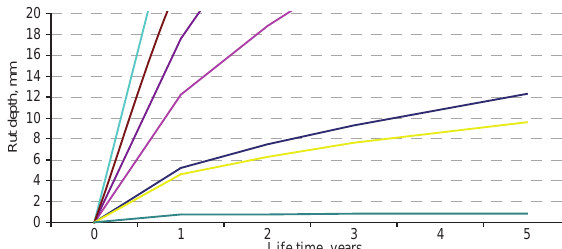
Table 6. Wheel tracking slope WTS AC mixture type